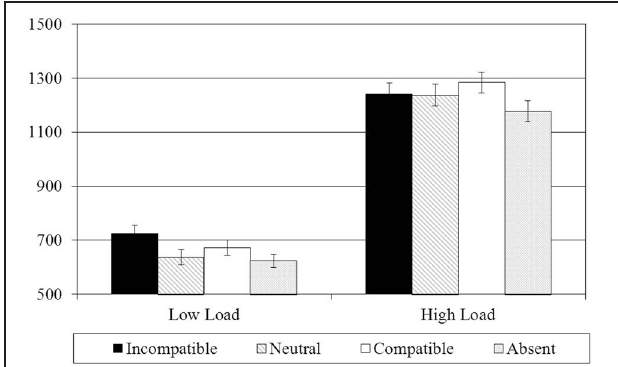
FIGURE 2 | Mean RTs (in ms) shown as a function perceptual load and distractor condition in Experiment 1. Error bars reflect the standard error of the